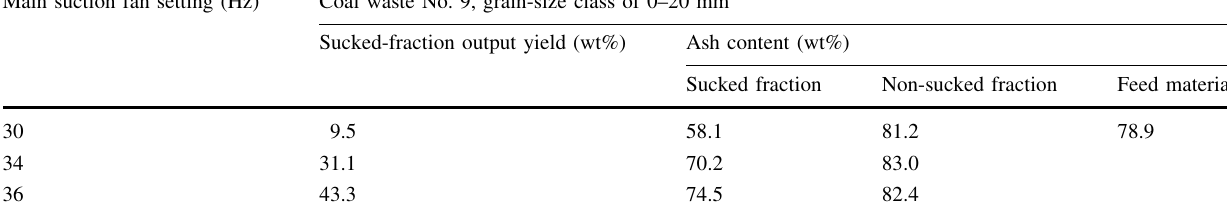
Table 11 Ash content of the feed material (coal waste) and sucked fraction Main suction fan setting (Hz)